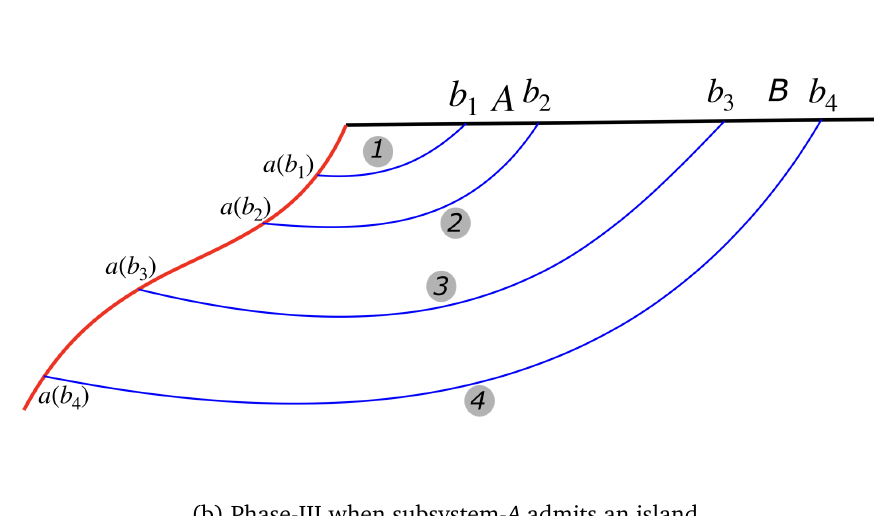
Figure 9: Schematic of island proposal-I for the entanglement negativity of the mixed state configuration of the disjoint intervals in